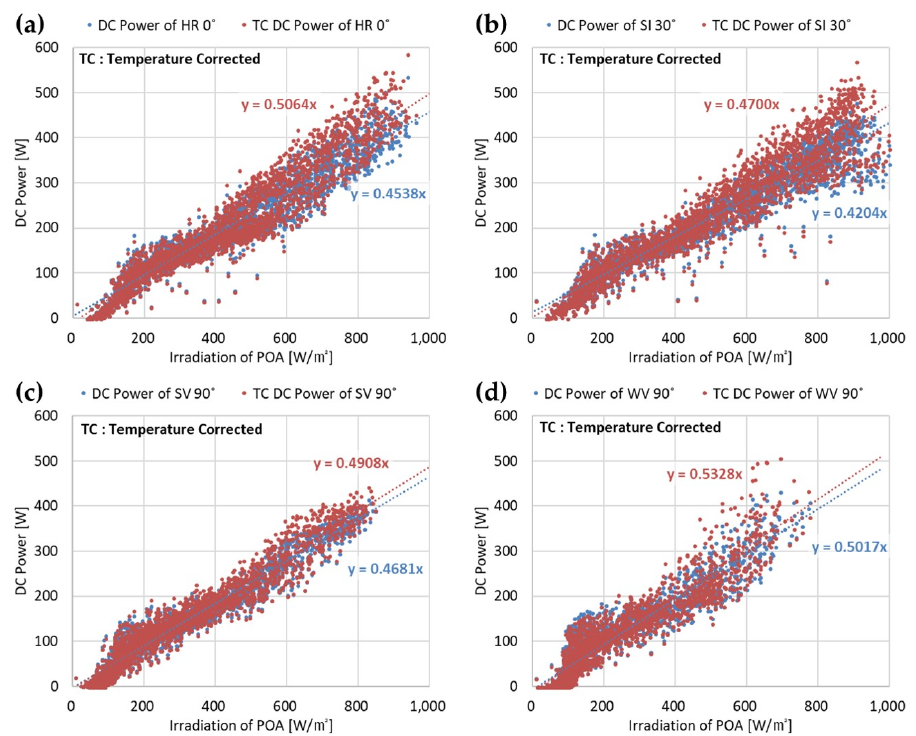
Figure 6. Direct current (DC) power and temperature corrected DC power trend to each array in relation